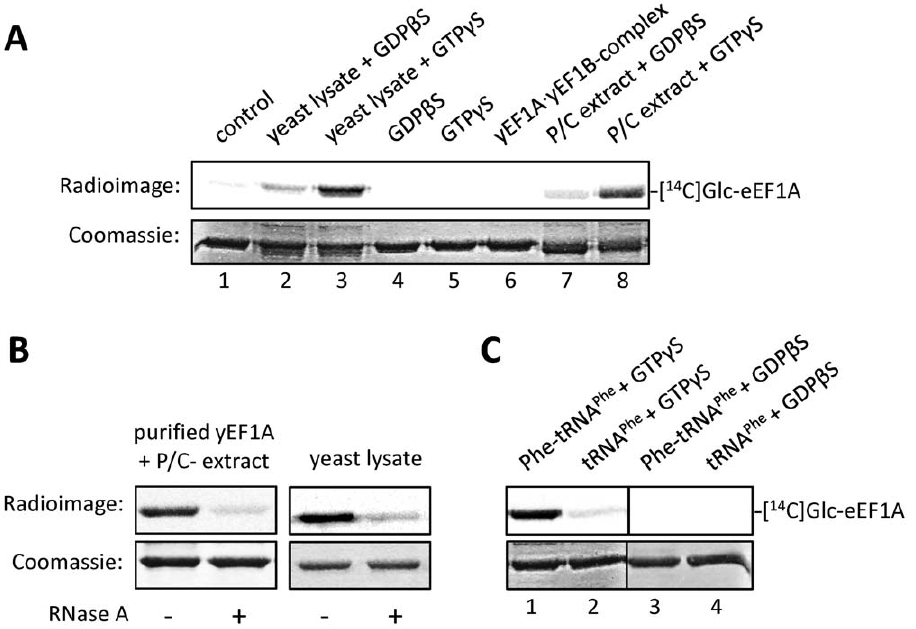
Figure 2. Analysis of yeast eEF1A (yEF1A) glucosylation by Lgt3. (A) Glucosyltransferase reaction was performed with Lgt3 (140 nM) and yeast eEF1A (3 m M) with UDP-[ 14 C]glucose (10 m M) for 15 min at 30 u C in the presence of either GDP b S (75 m M) or GTP c S (75 m M) and the following components: purified yeast eEF1A (control, lane 1), yEF1A with freshly prepared yeast cell lysate (30 m g) (lane 2 and 3), yEF1A in the presence of GDP b S (75 m M) (lane 4) or GTP c S (75 m M) (lane 5), yEF1A ? yEF1B a complex (3 m M each) (lane 6), yEF1A with 5 m l phenol/chloroform extract (P/C